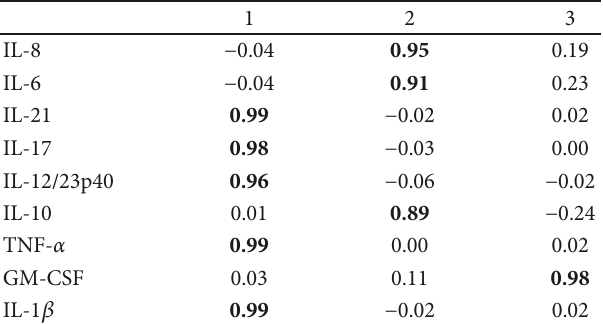
Figure 1: Kinetics of cytokines (observed means in pg/mL) on days 1, 2, 3, 5, and 14 of fever in febrile neutropenic patients. For better visualization, IL-21 (near absent expression) and G-CSF (very high levels due to fi lgrastim administration) were not shown. Table 4: Factor analysis loadings of the three factors of the solution. Loadings > 0.7 (in bold) con fi rm that variables are represented by each